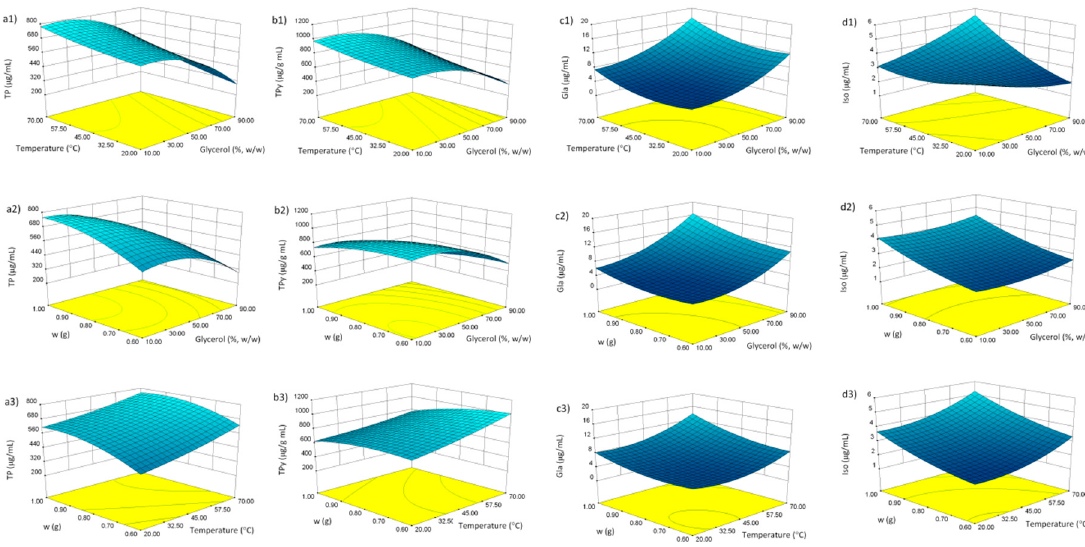
Figure 1. Response surface plots for content of phenols in licorice root extracts: Total phenols (TP) ( a1 – 3 ), TP / X 3 (TPy) ( b1 – 3 ), glabridin (Gla) ( c1 – 3 ), and isoliquiritigenin (Iso) ( d1 – 3 ). For significant model terms, see Table 3.